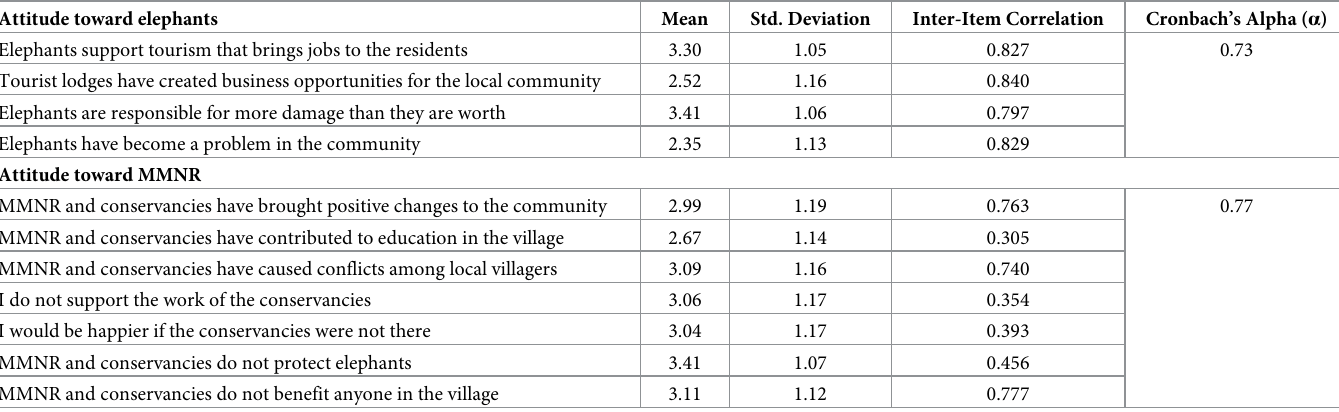
Table 2. Results of the reliability analysis.